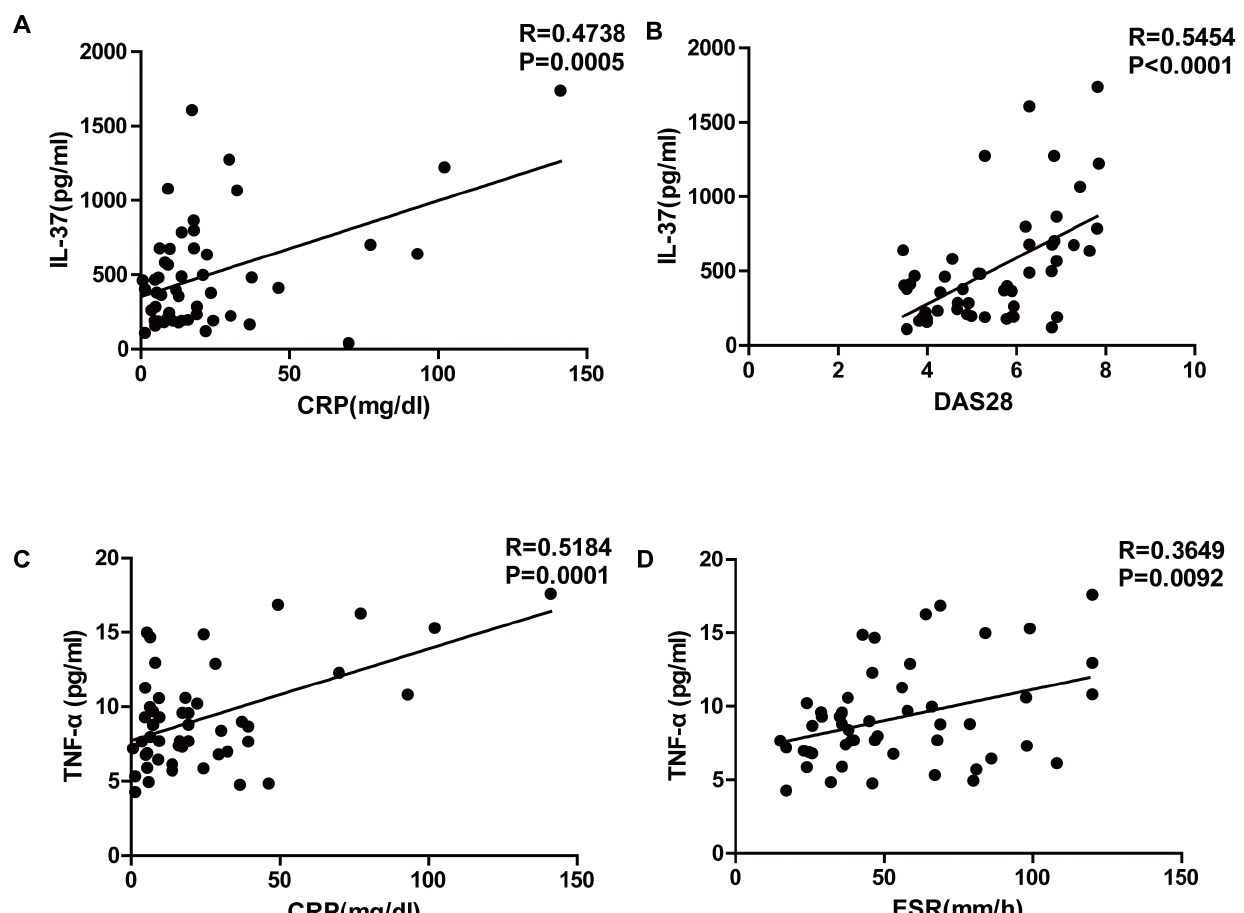
Figure 4. Correlation between plasma levels of IL-37 and disease activity in RA patients. ( A ) Correlation between plasma levels of IL-37 and CRP in RA patients. ( B ) Correlation between plasma levels of IL-37 and the DAS28 score in RA patients. The relationship between variables was evaluated using the Spearman rank correlation test.